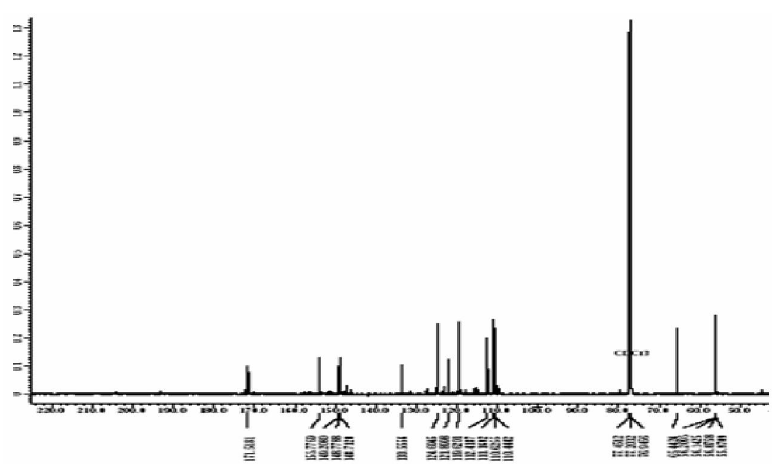
Figure 7. 13 C-NMR spectrum of 2',5'-dihydroxy-3,4-dimethoxy chalcone